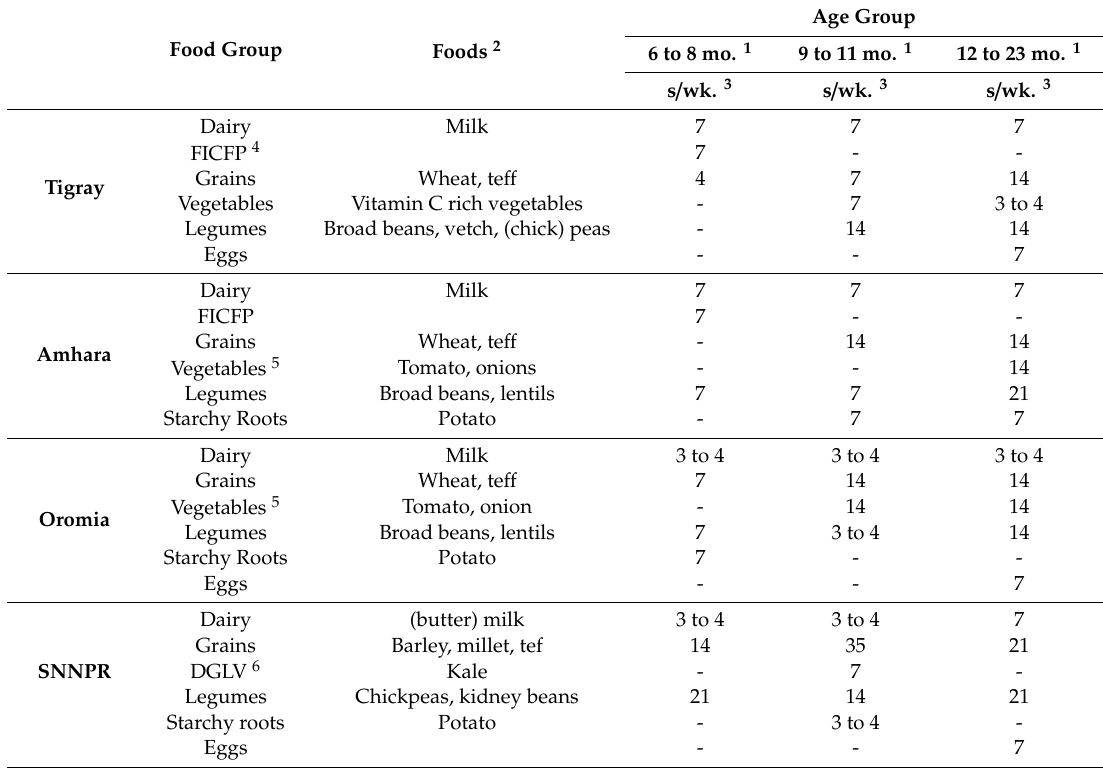
Table 4. Summary of food-based recommendations (in addition to breastmilk) for young Ethiopian children, for di ff erent age groups per